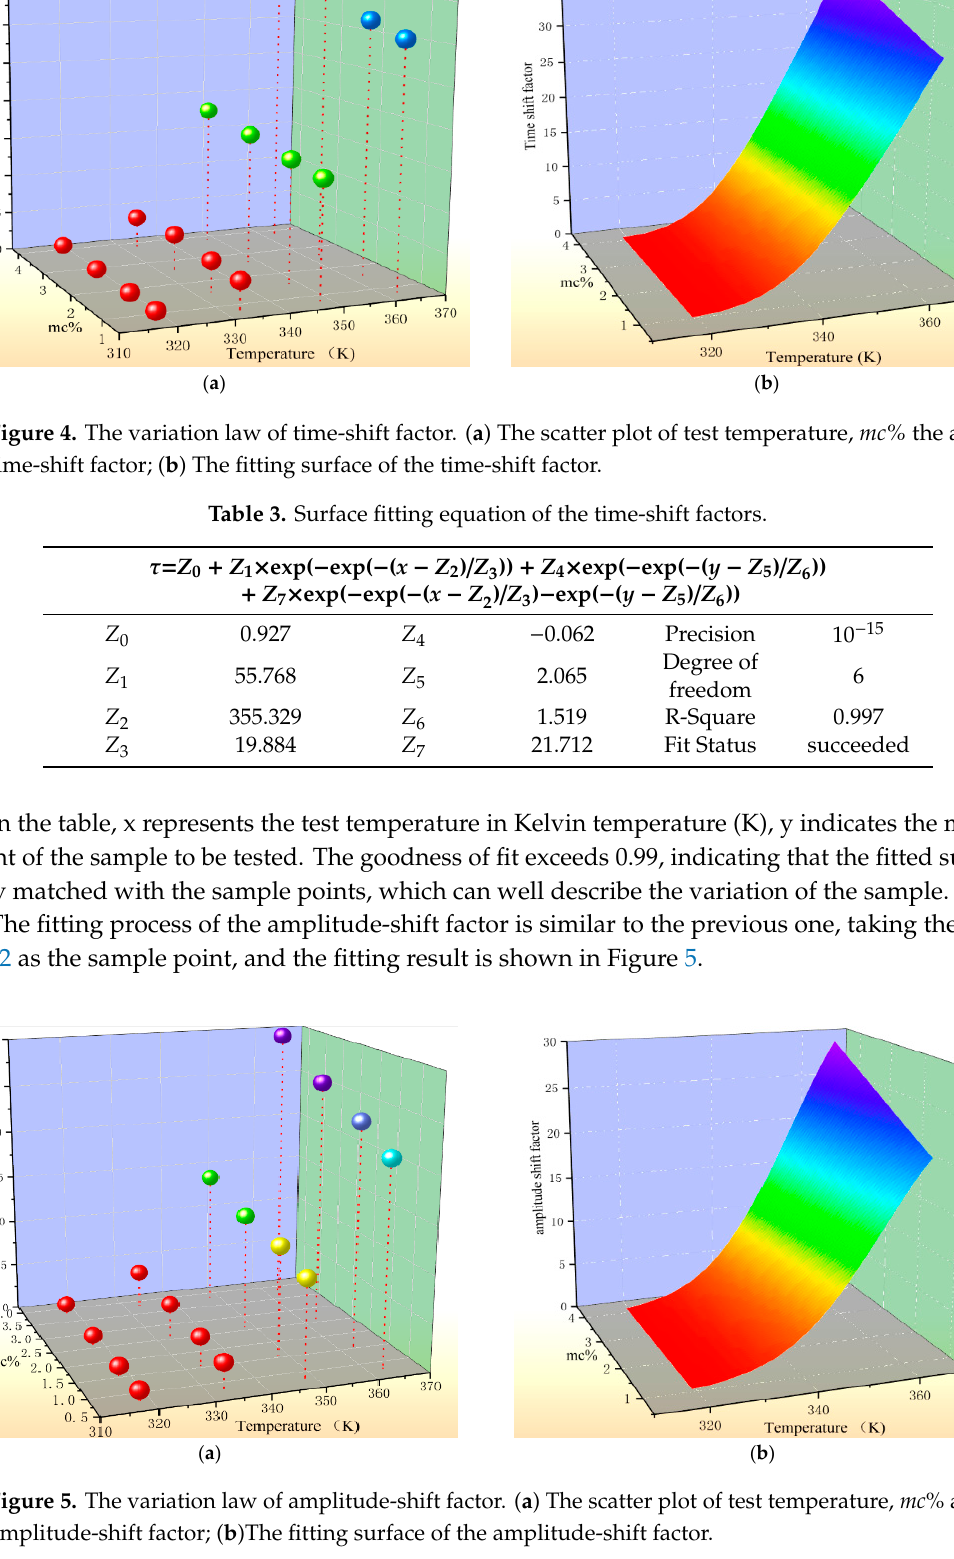
Figure 5. The variation law of amplitude-shift factor. ( a ) The scatter plot of test temperature, mc % and amplitude-shift factor; ( b )The fitting surface of the amplitude-shift factor.